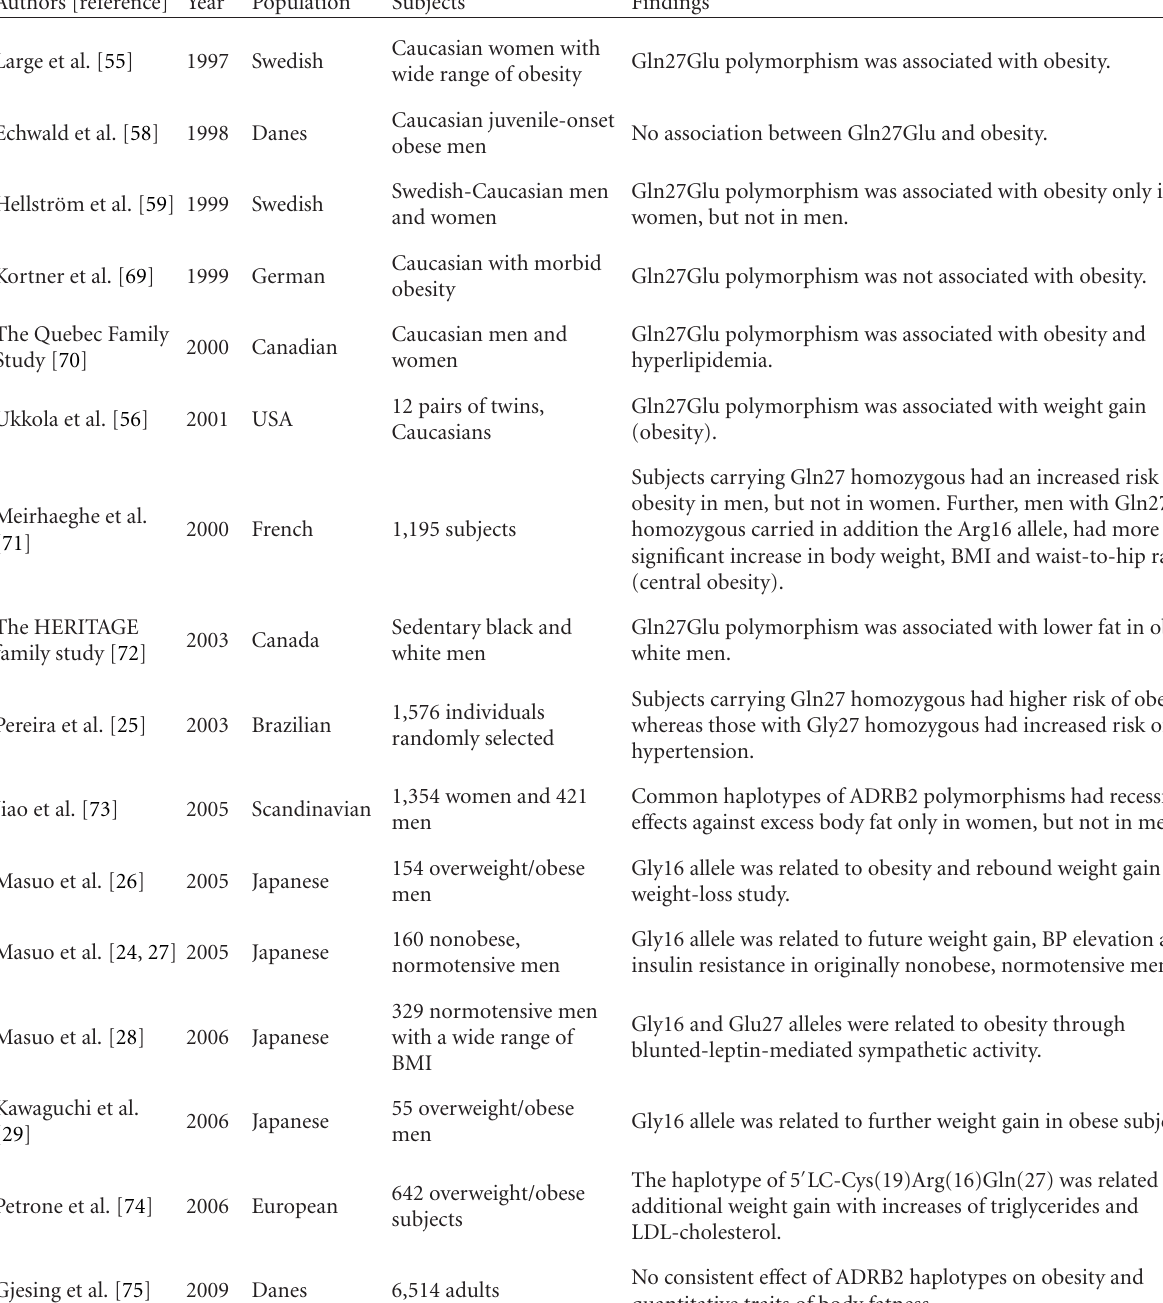
Table 2: Summary of studies showing associations between β 2-adrenoceptor polymorphisms and